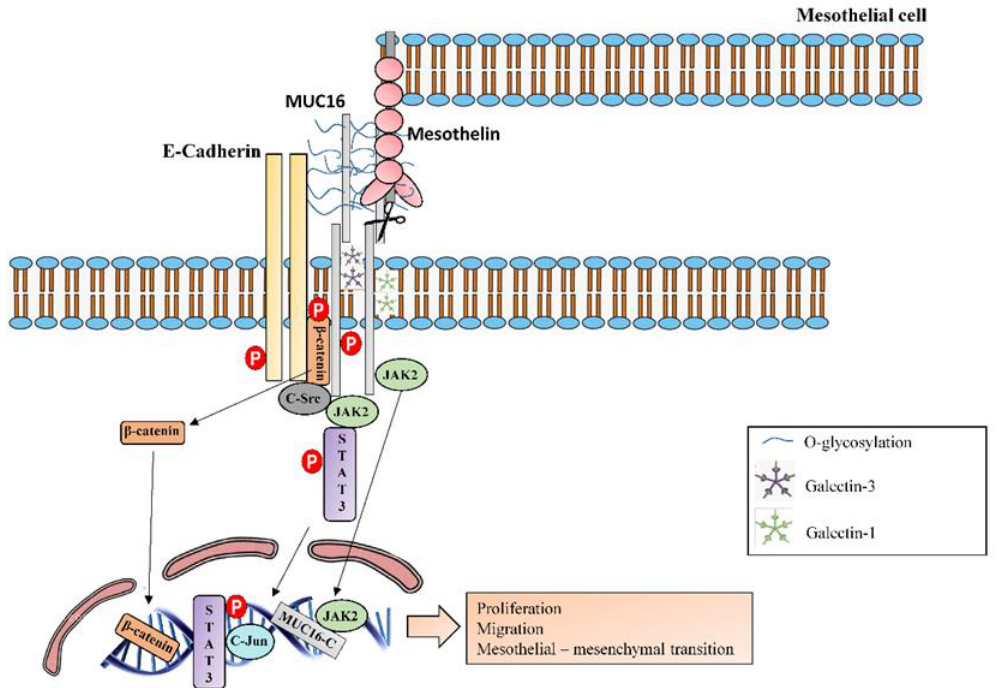
Figure 12. MUC16 molecular interactions and intracellular signalling. MUC16-C terminal subunit colocalizes into the nucleus with JAK2 and they both impart tumorigenic and metastatic functions. Furthermore, MUC16-C terminal subunit also associates with JAK2 in the cytoplasm and consequently activates STAT3 and c-Jun to promote cell proliferation. MUC16 has been observed associated with E-cadherin and β -catenin complexes and it inhibits GSK-3 β -mediated phosphorylation and degradation of β -catenin, leading to increased levels of the fibrogenic transcription factor β -catenin. It is suggested that the cytoplasmic tail of MUC16 could bind to β -catenin and that the extracellular domain of MUC16 could interacts with the extracellular domain of E-cadherin and stabilizes E-cadherin at the cell membrane. MUC16-CT directly binds the c-src kinase, which phosphorylate it. C-src also mediates tyrosine phosphorylation of E-cadherin, inducing its ubiquitination and degradation. Otherwise, β -catenin phosphorylation by c-Src negatively regulates the binding to E-cadherin. Therefore, β -catenin is translocated into the nucleus. MUC16 extends from the surface and binds to mesothelin, a protein that is found on the surface of the mesothelial cells, activating MUC16 and enhancing epithelial mesothelial to mesenchymal